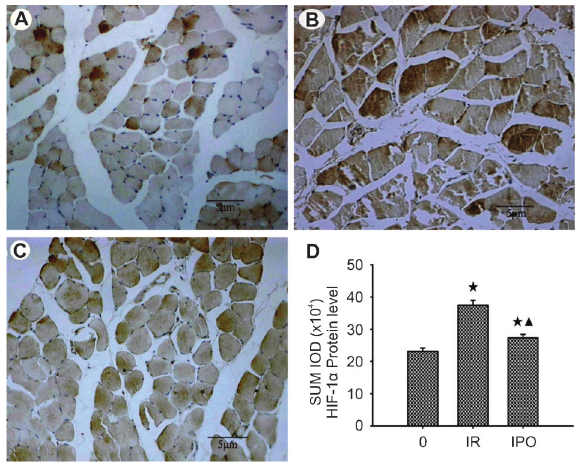
Figure 5. Photomicrographs of hypoxia-inducible factor-1 a (HIF- 1 a ) immunohistochemistry in skeletal muscle tissue. The thick- ness of skeletal muscle containing HIF-1 a -positive skeletal muscle cells was determined at 3 h. Scale bar: 5 m m. A , Weak staining of skeletal muscle cytoplasm and nucleus, of vascular endothelial cytoplasm and nucleus, and of inflammatory cyto- plasm and nucleus, in sham-operated control (C) group skeletal muscle. B , Strong staining of skeletal muscle cytoplasm and nucleus, of vascular endothelial cytoplasm and nucleus, and of inflammatory cytoplasm and nucleus, in ischemia-reperfusion (IR) group skeletal muscle. C , Moderate staining of skeletal muscle cytoplasm and nucleus, of vascular endothelial cyto- plasm, and of inflammatory cytoplasm and nucleus, in ischemic postconditioning (IPO) group skeletal muscle. Note that there were significant differences in the expression of HIF-1 a between sham-operated, IR, and IPO groups. D , SUM IOD (integrated absorbance value) of HIF-1 a protein level in sham-operated, IR, and IPO groups of skeletal muscle tissue (n=36). Data are reported as means±SD. w P , 0.01 vs sham-operated group; m P , 0.01 vs IR group (one-way ANOVA).